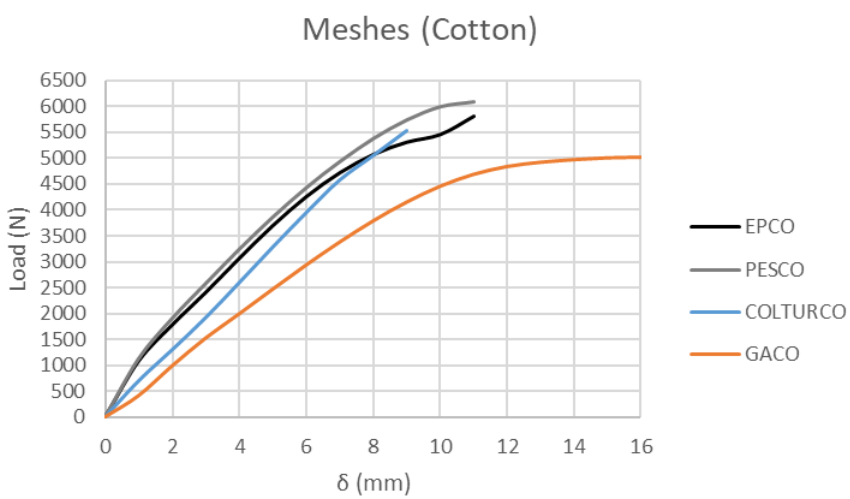
Figure 7. Load–Extensometer curves for cotton Figure 7. Load – Extensometer curves for cotton meshes.